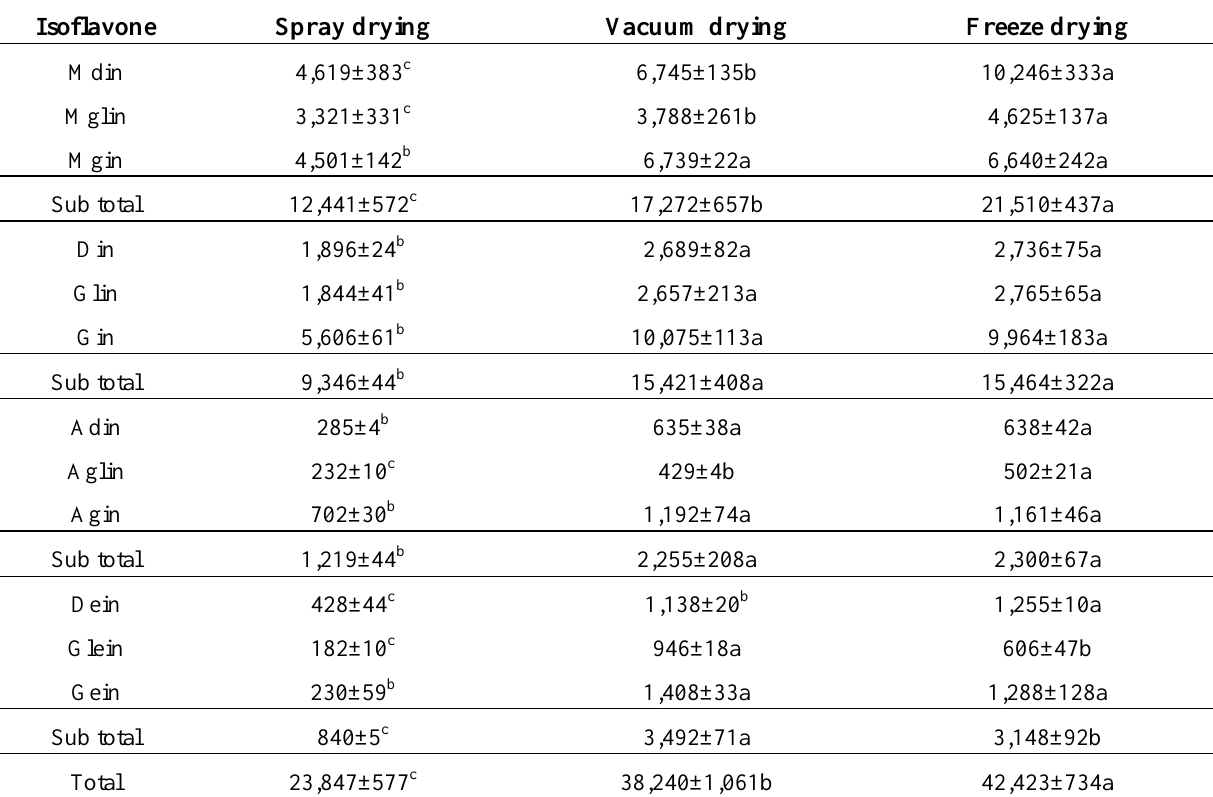
Table 1. Effect of drying methods on isoflavone contents ( μ g/g) A in a powder with 1 % sodium alginate as carrier B